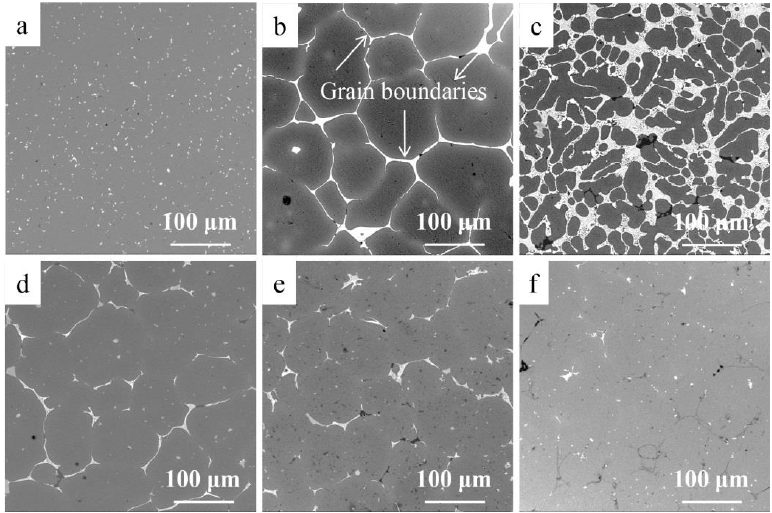
Figure 4. Morphology of raw material ( a ), after heat treatment in trail 11 ( b ) and different layers (( c ): layer 1, ( d ): layer 2, ( e ): layer 3, ( f ): layer 4) in trail 4 (BSE mode).